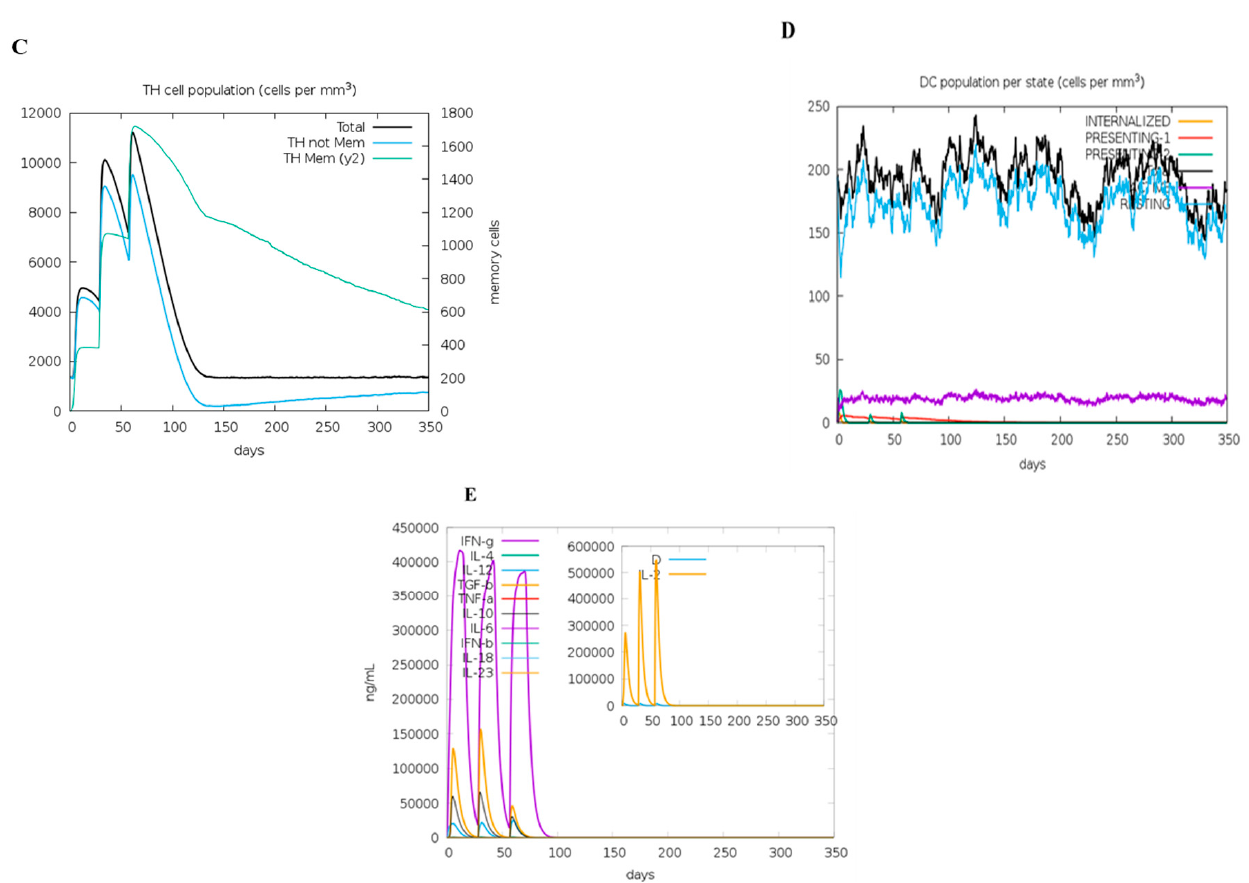
Figure 15. Simulation of the immunological response of the multiepitope-based vaccination construct in silico, ( A ) represents antibody production. In contrast, the black vertical lines show antigen, ( B ) B lymphocytes Population after three injections, ( C ) helper T cell activation throughout the injections, ( D ) Throughout the injections, the active cytotoxic T cell population in each state increased, ( E ) Concentration of cytokines and interleukins with Simpson index